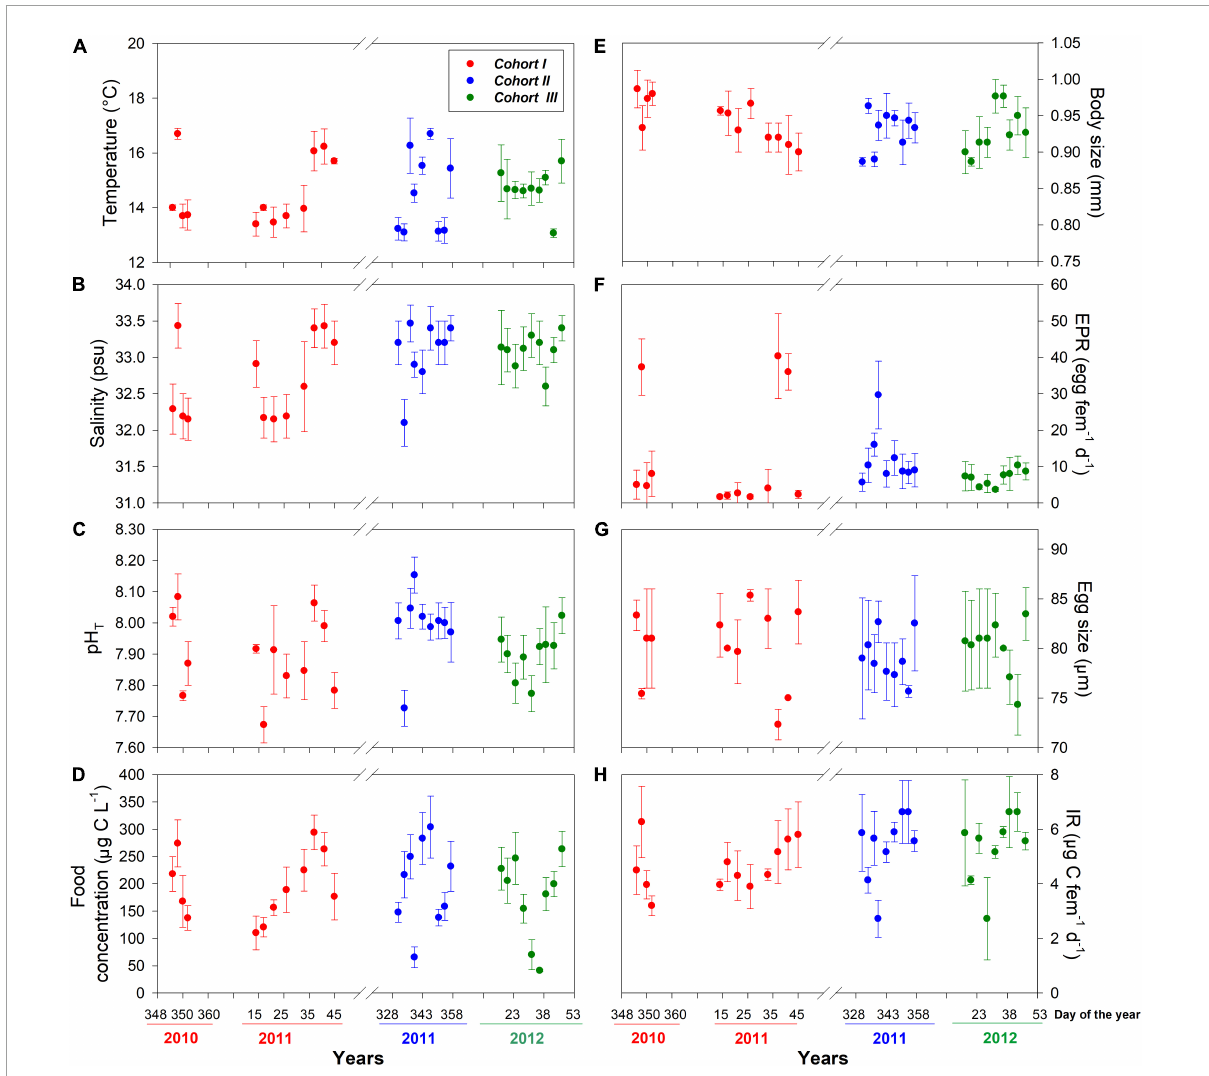
FIGURE1 Interdaily mean ( ± SD) values of environmental drivers (A–D) and copepod traits (E–H) assessed for three different cohorts at the estuarine habitat. Sampling was conducted during the seasonal occurrence and reproductive period of the local A. tonsa population.